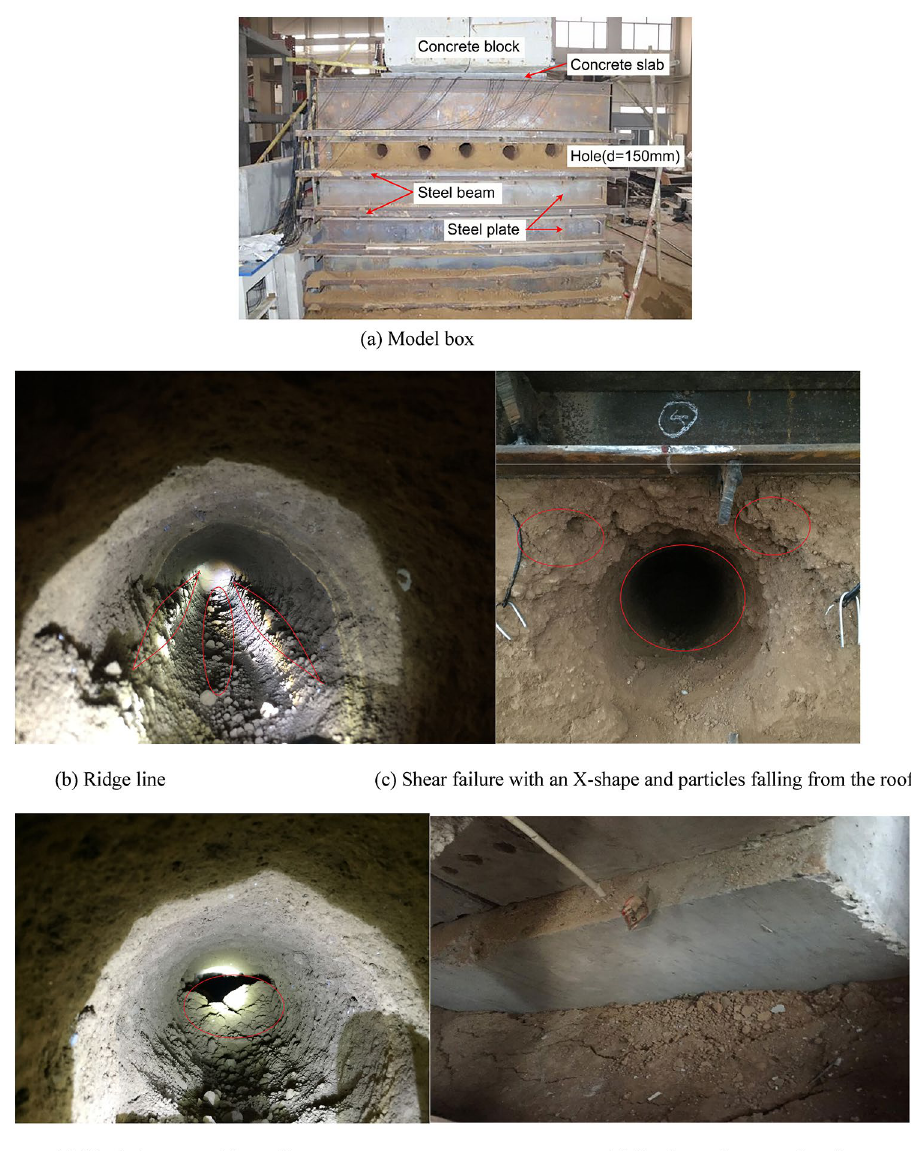
Fig. 6 Model box and typical observations, a Model box, b Ridge line, c Shear failure with an X-shape and particles fall- ing from the roof, d The hole approaching collapse, e Cracks on the ground